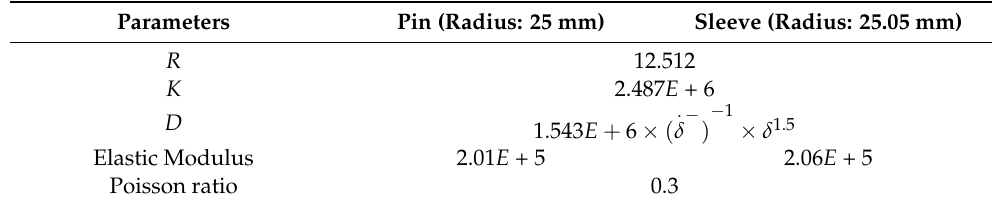
Table 1. Stiffness coefficient and damping coefficient of joint.